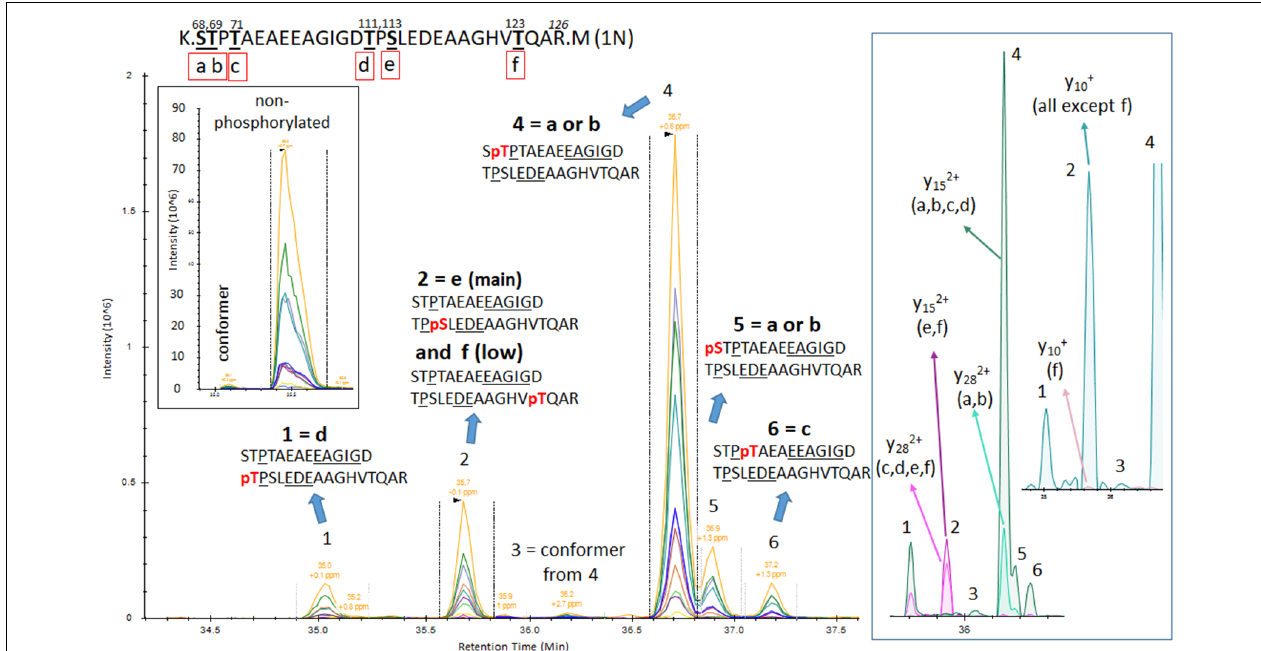
FIGURE 3 | PRM screening of mono-p-tau sequence 68–126 (1N isoform) containing six potential phosphorylation sites. Three phosphorylation sites are shared by peptides containing residues 103–126 as described in Figure 2 (d–f). Six LC-MS patterns were identified. The Y28 fragment carrying phosphate, shared by pS68 (a) or pT69 (b), is found in the two LC-MS patterns 4 and 5. This demonstrates the existence of the two phosphorylated peptides but corresponding LC-MS patterns cannot be strictly assigned without the detection of ion fragment y29 to differentiate pS68 and pT69. Specific fragments corresponding to pT71 (c) and pT111 (d) are found in LC-MS patterns 6 and 1, respectively. Specific fragments for pS113 (e) and pT123 (f; y15 with phosphate) are found in the LC-MS pattern 2. This pattern contained both y10 fragments with and without phosphate, suggesting the co-elution of these two phosphorylated peptides. Since y10 without phosphate has the major signal in comparison to y10 with phosphate, the degree of pT123 is likely lower than pS113. LC-MS pattern three is attributed to a minor conformer or LC artifact from the phosphorylated peptide from pattern four as found for the non-phosphorylated